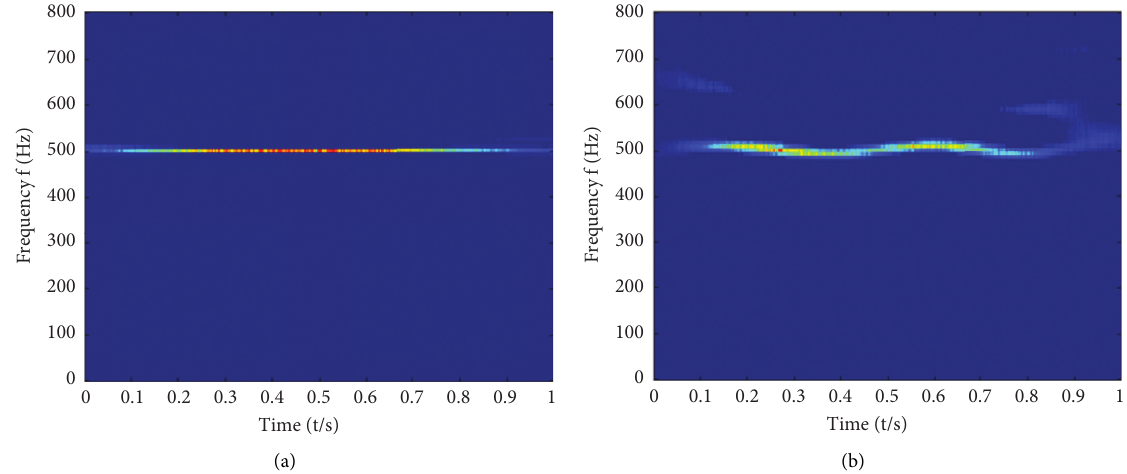
Figure 13: Time-frequency spectrum of fault signal adopted by two